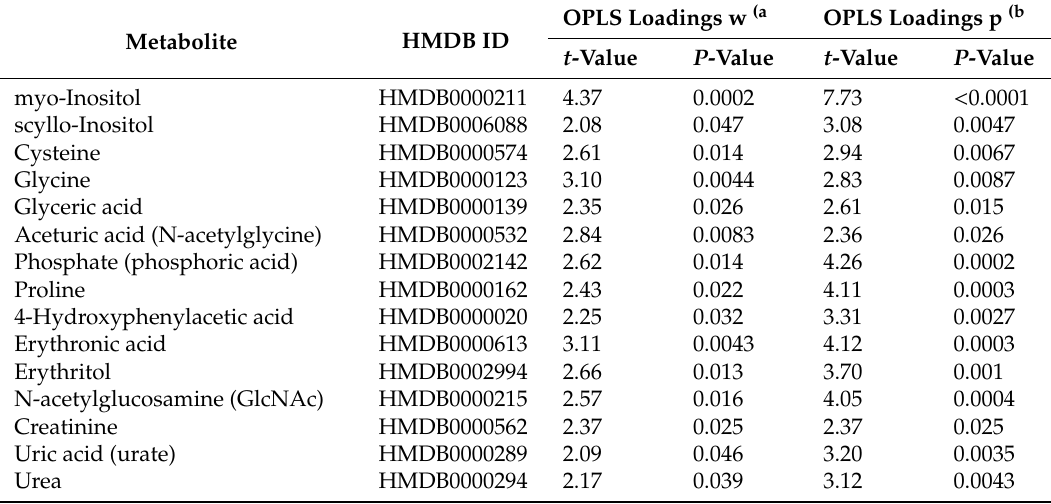
Table 2. Summary of significant